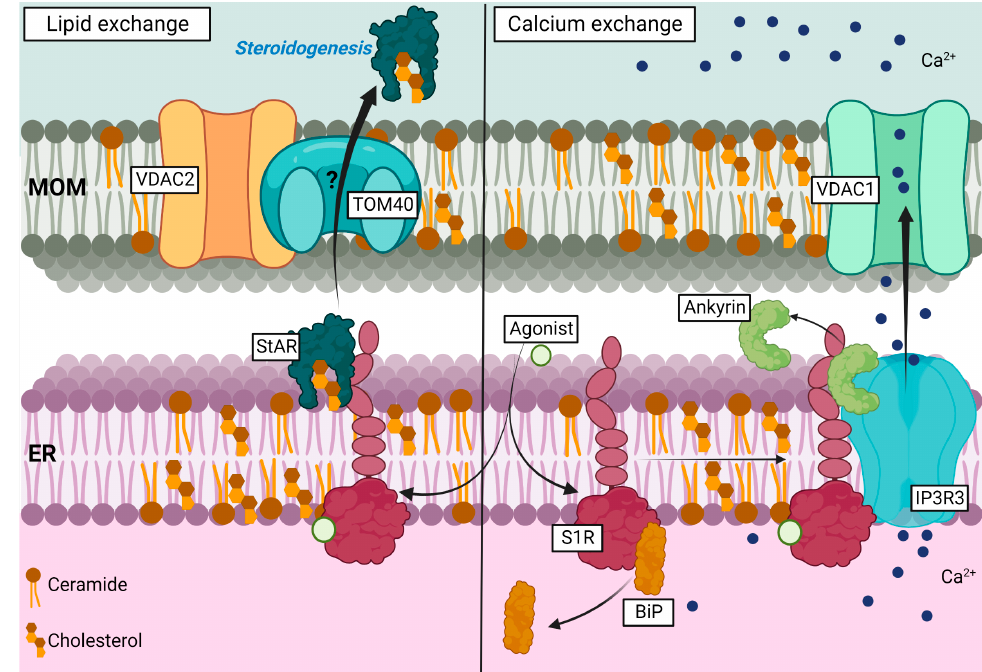
Figure 2. Representation of S1R role in lipid and calcium exchanges observed in lipid raft at the MAM. Left side; agonist-induced activity of S1R promotes its interaction with StAR and supports cholesterol exchange between ER and mitochondria through interaction with VDAC2 and potentially TOM40, which enhances steroidogenesis. Right side: Upon agonist-binding, S1R dissociates from BiP and associates with IP3R3. S1R binding to IP3R3 promotes Ankyrin protein dissociation’s from IP3R3 and supports calcium exchange from the ER to mitochondria. MOM (mitochondria outer membrane).